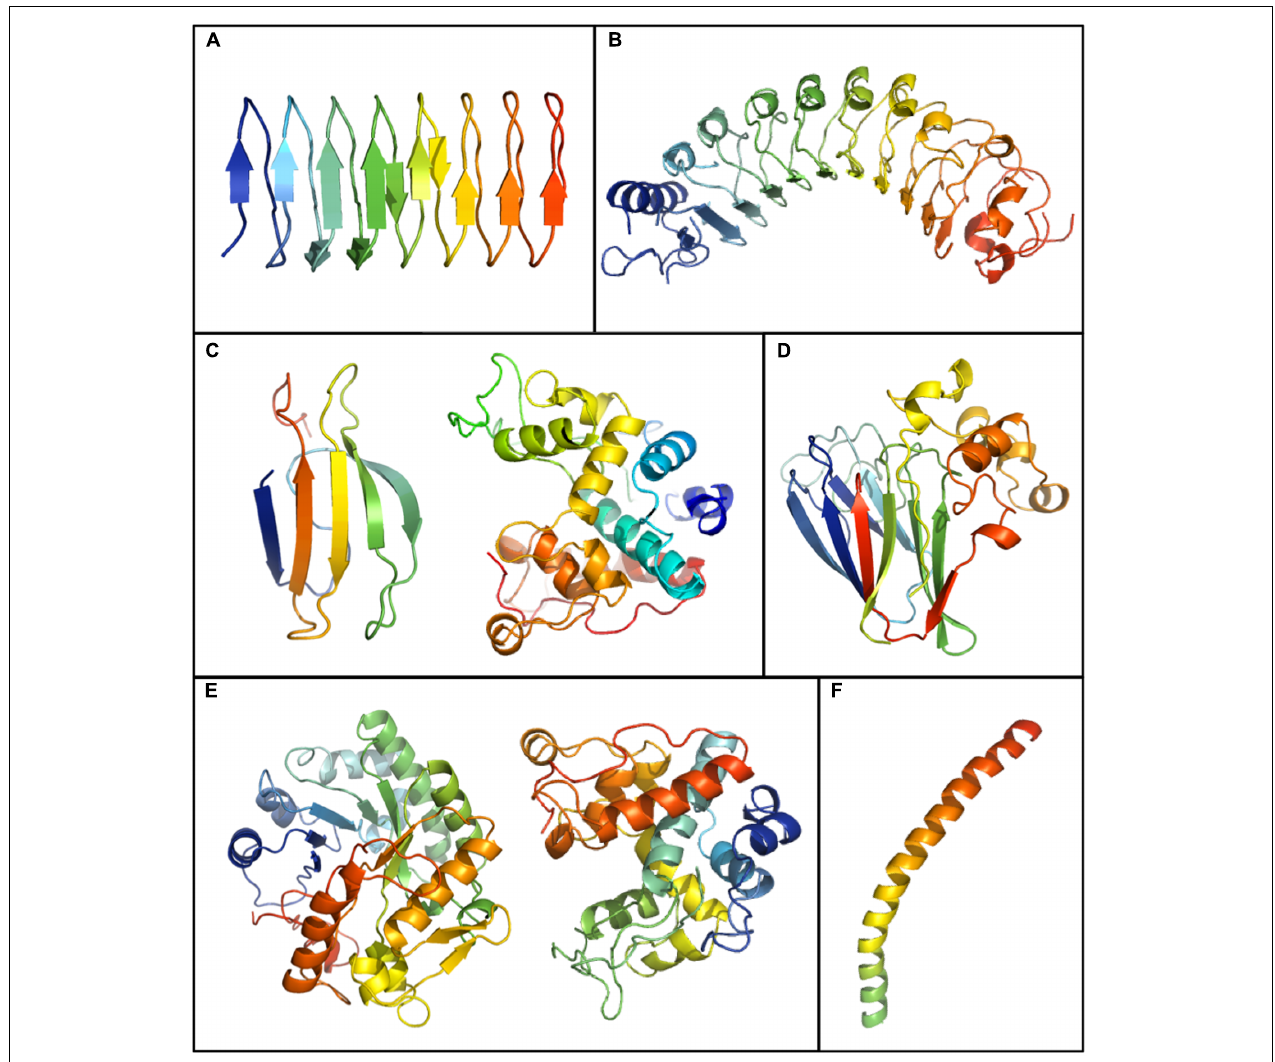
FIGURE 3 | Plant IBP models generated by running GenBank sequences through the Phyre 2.0 server (http://www.sbg.bio.ic.ac.uk/phyre2/html/page.cgi?id=index). Shown is the crystal structure of the IBP domain of Lolium perenne , Lp AFP (GenBank ID: AJ277399.1) (A) and models for: Daucus carota Dc AFP (AF055480.1) (B) , a WRKY-IBP (STHP) (AAL268542.1) (left) and a type I endochitinase-IBP (Q84LQ7) (right) from Solanum dulcamara (C) , Triticum aestivum thaumatin like-IBP (AAM15877.1) (D) , a glucanase-IBP (CAJ58506.1) (left) and a type II endochitinase-IBP (right) (AF280438.1) from Secale cereal e (E) , and an IBP from Chorella vulgaris (ABR01234.1) (F)